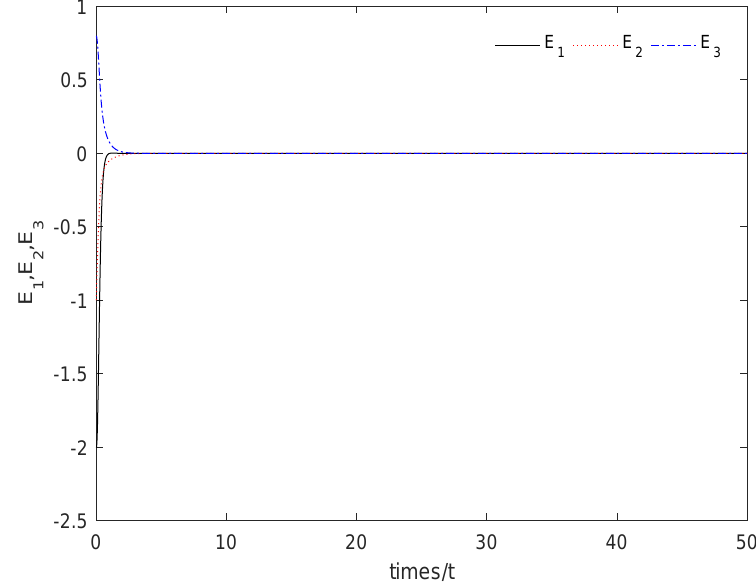
Figure 9. The sum system (21) is asymptotically stable.